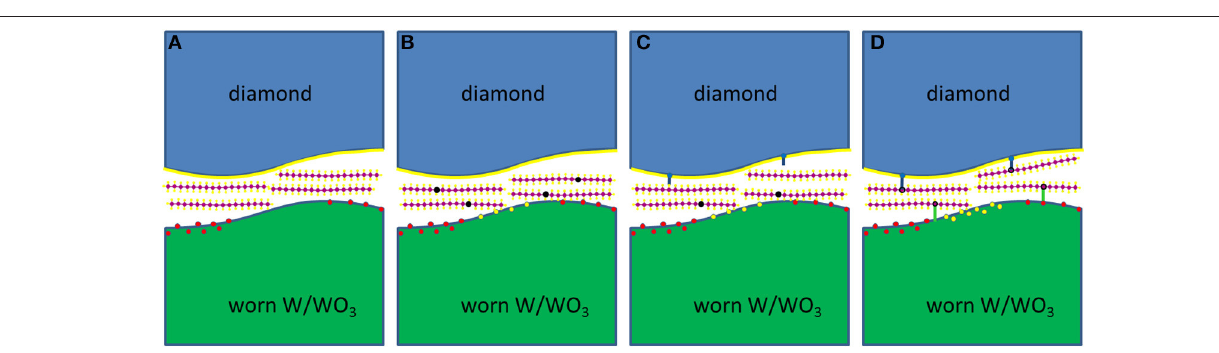
FIGURE 6 | Schematic of a probable reaction path for the radicalization and chemical adsorption of hydrocarbon molecules between W/diamond and WO 3 /diamond sliding interfaces. (A) Sliding of diamond against the tungsten counterbody under high loads results in wear of the WO 3 material that passivates the tungsten surface. This creates reactive patches of worn W and/or WO 3 . (B) These reactive sites can then easily radicalize the initially saturated hydrocarbon molecules. (C) The radicalized molecules can then remove passivating H atoms (or OH groups) from the diamond surface, resulting in the creation of reactive sites on the diamond surface. (D) The remaining radical molecules can then bond onto reactive sites on the diamond surface or on the worn W/WO 3 surface. The preferential bonding of the radicals on the diamond and WO 3 surfaces can eventually result in the formation of hydrocarbon layers attached to the diamond and WO 3 surfaces, while desorption of the absorbed molecules on WO 3 sites can result in the formation of molecules with O and/or OH groups, which can eventually also be adsorbed onto the diamond